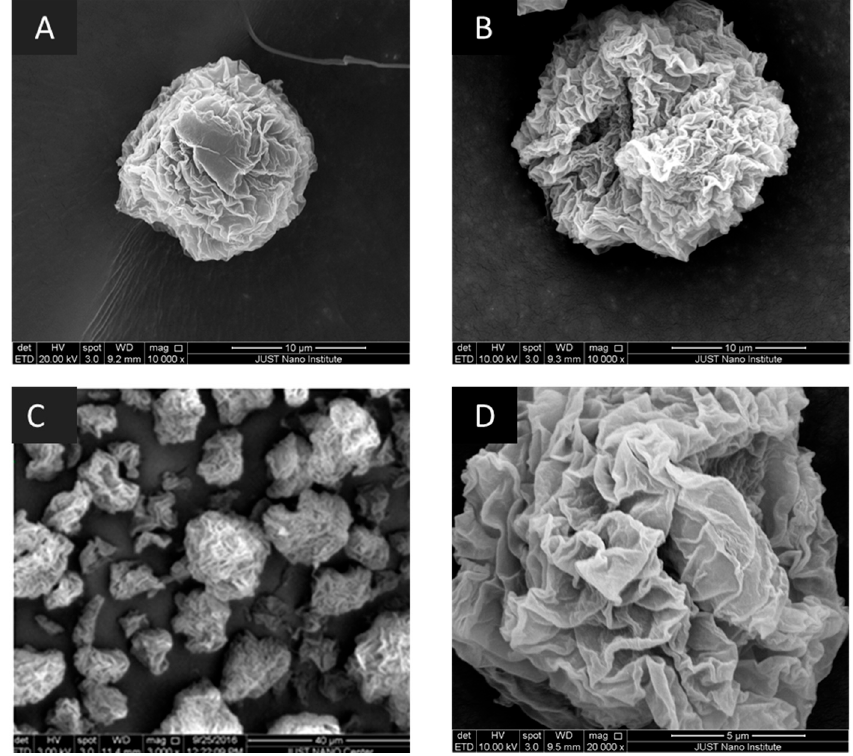
Figure 1. Scanning electron microscopy (SEM): ( A ) images for S1 at 10,000 × ; ( B ) image for S2 at 10,000 × ; ( C ) Sample S4 at 3000 × ; ( D ) Sample S4 at 20,000 × . Selected samples are presented with acceptable calculated aerodynamic diameter.